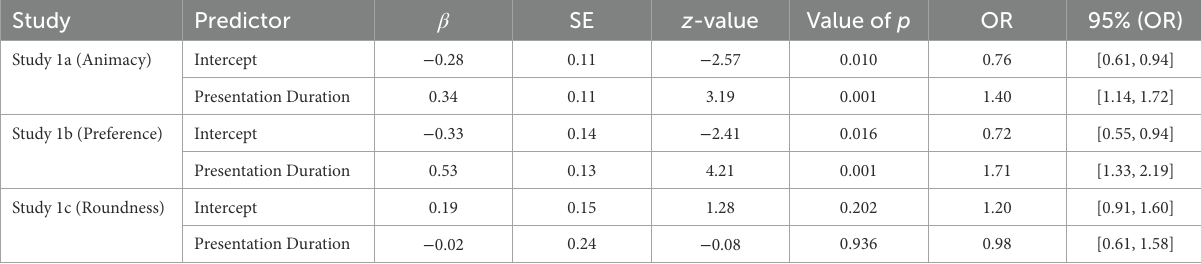
TABLE 1 Fixed effects from the GLMM analyses through Studies 1a to